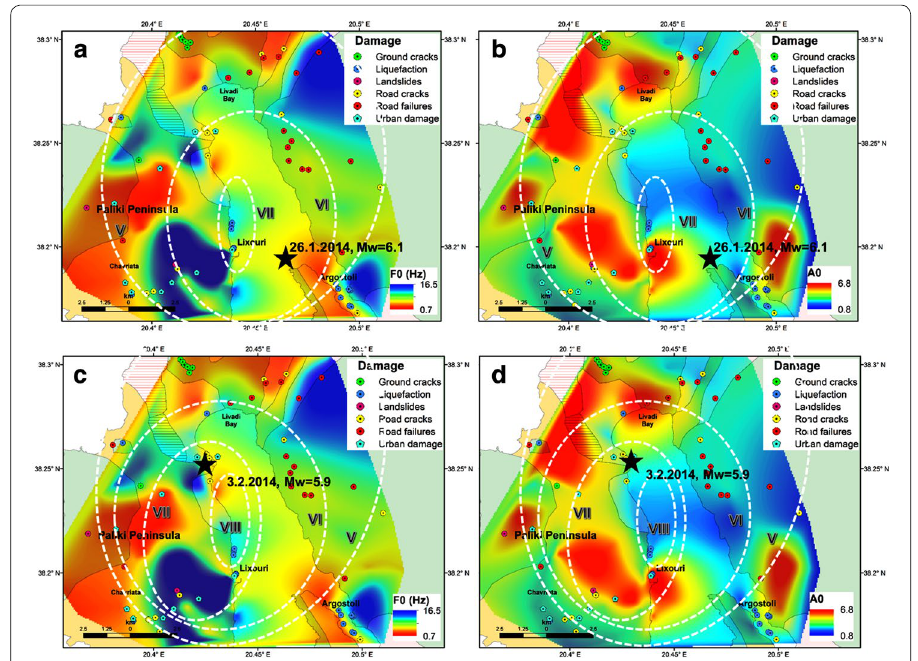
Fig. 11 Maps presenting the HVSR resonant peaks distribution (F0 and A0) with respect to geoenvironmen- tal and structural damage observations [49] in western Cephalonia after the 26.1.2014 ( a , b ) and 3.2.2014 ( c , d ) earthquakes. The dashed ellipses denote isoseismal lines (after [37]). Red colors indicate low frequency and high amplification, while blue colors indicate high frequency and